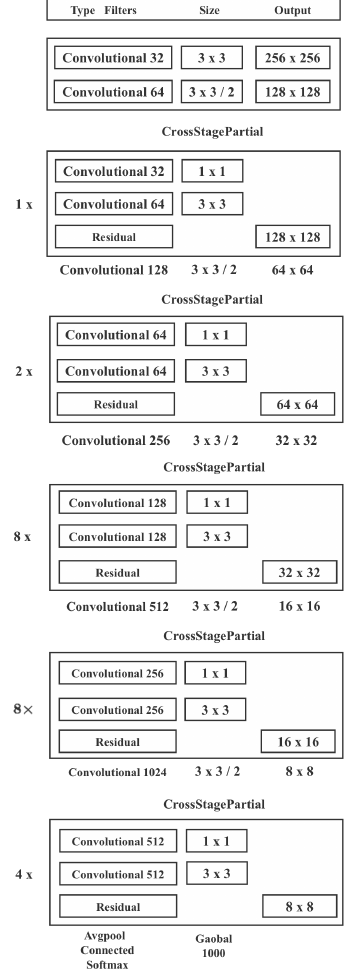
Figure 7. The ultimate structure of CSPDarknet53.